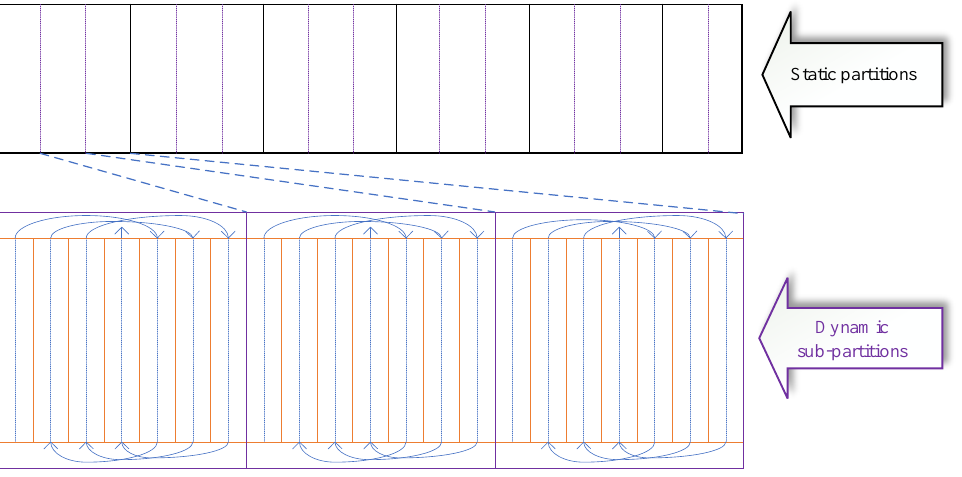
Figure 4. Dynamic partitioning for several sets of machinery units.